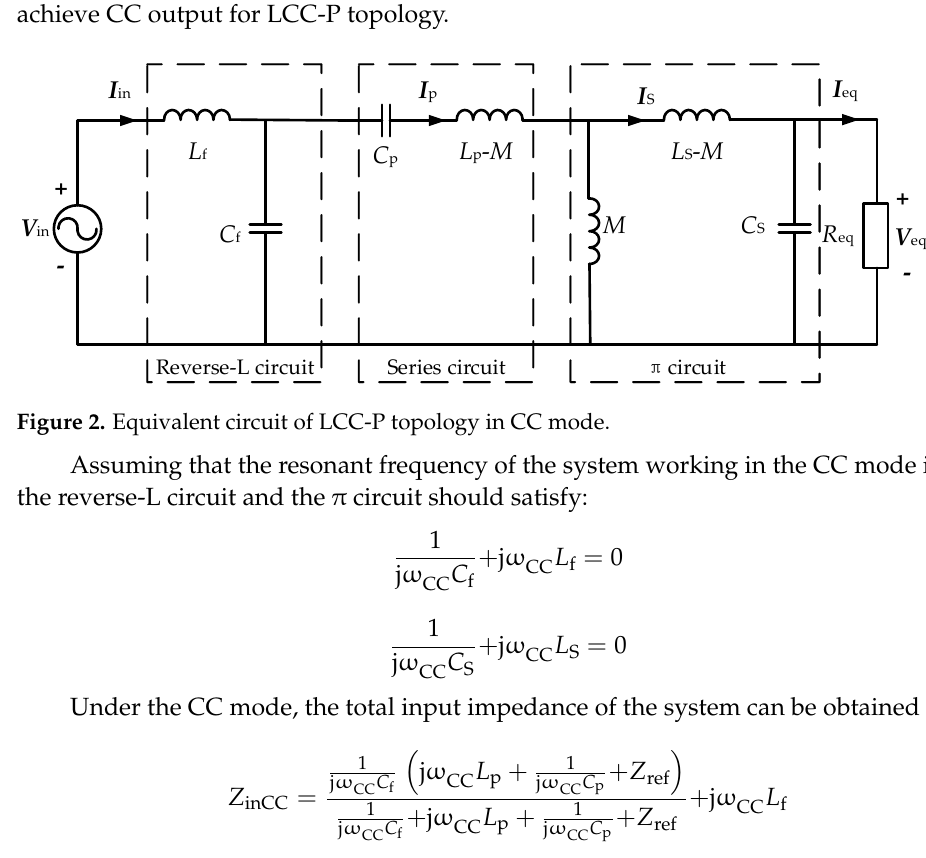
Figure 1. The circuit topology with LCC-P compensation.